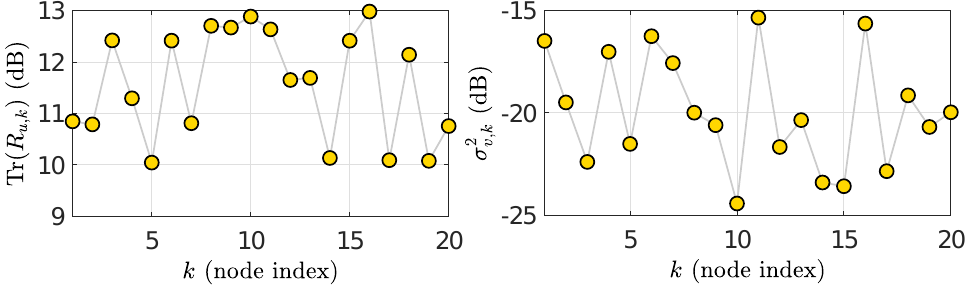
Figure 3. The network statistical settings: regressor power profile ( Left ) and observation noise power profile ( Right